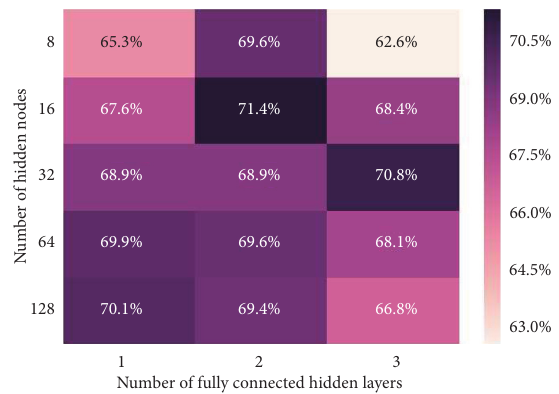
Figure 4: Heatmap of model performances with different hidden layers and nodes in cross